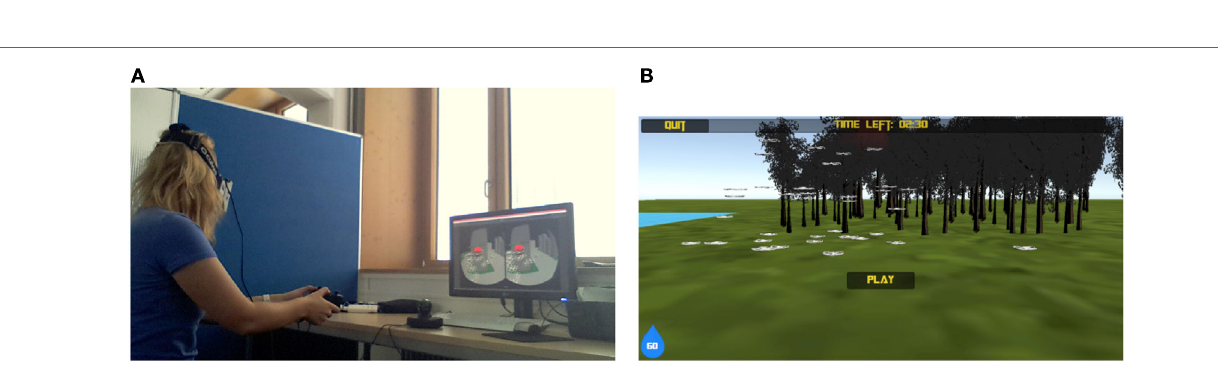
FigUre 12 | (a) The user guides the swarm through movement of her head and two 3D joysticks. The pair of controllers empowers her to draw new spatial relations between the simulated objects, e.g., to set new targets for subsets of the swarm. © 2014 IEEE. Reprinted, with permission, from von Mammen et al. (2014). (B) We are working on testing usability and user experience of different interfaces and input modalities [also based on indirect touch (Voelker et al., 2013) and hand-gestures (Hackenberg et al., 2011)] in the context of this fire-fighting game.